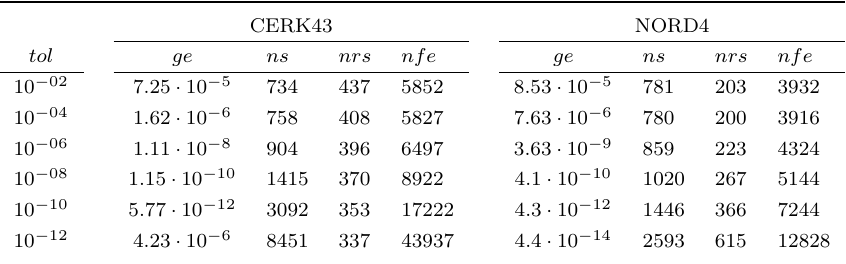
Table 7. Numerical comparison of CERK43 and NORD4 methods applied on the Prothero-Robinson equation (4.2), with standard stepsize control CERK43 NORD4